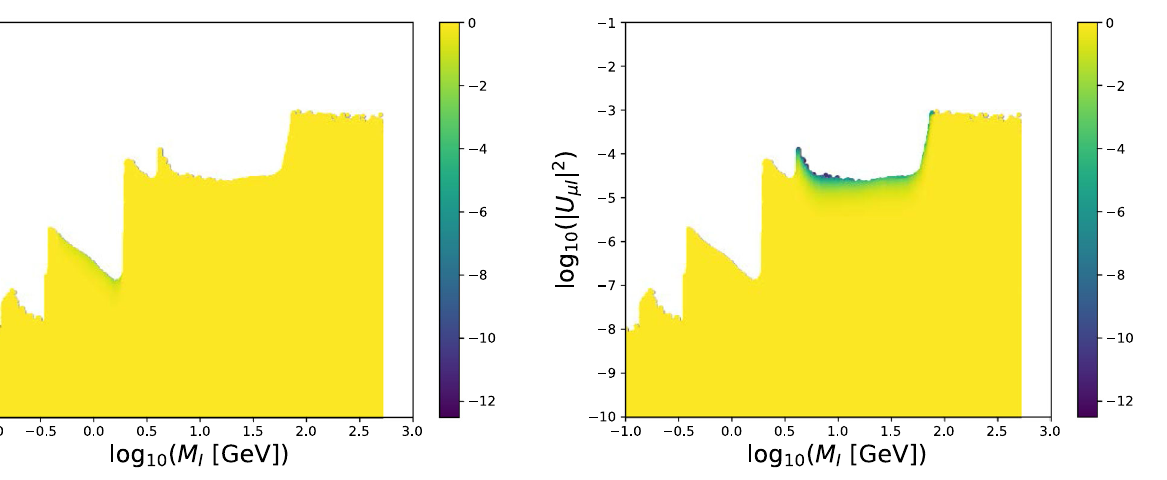
Fig. 27 Partial likelihood from direct searches with CHARM, μ - channel, in the M I − | U μ I | 2 plane